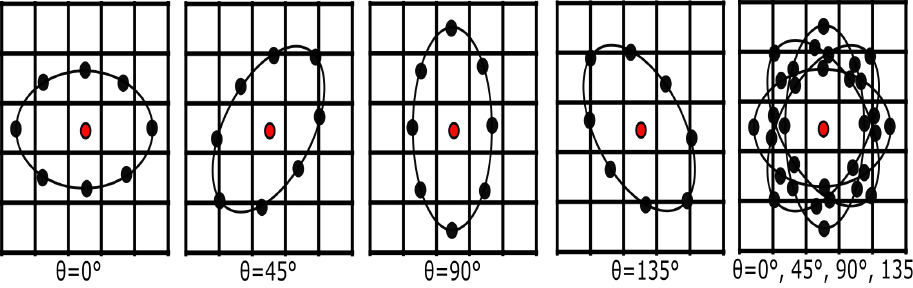
Figure 8. Ellipse topology at different orientations and its